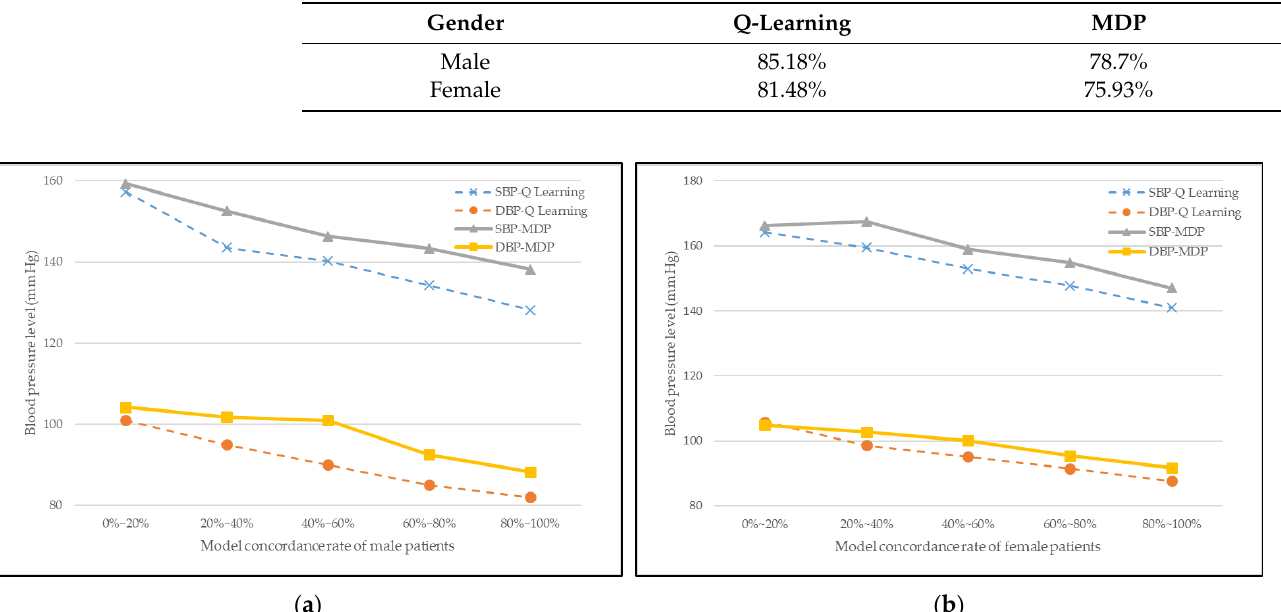
Figure 6. Relationship between patients’ model concordance rate and blood pressure level of Q-learning and MDP for ( a ) male patients and ( b ) female